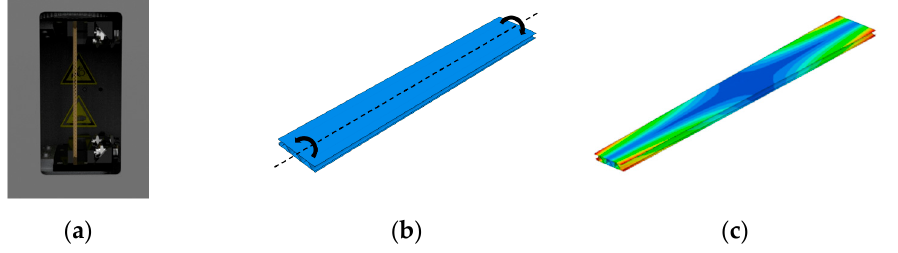
Figure 4. The torsional stiffness test: ( a ) cardboard testing device; ( b ) loaded sample; ( c ) deformed sample.